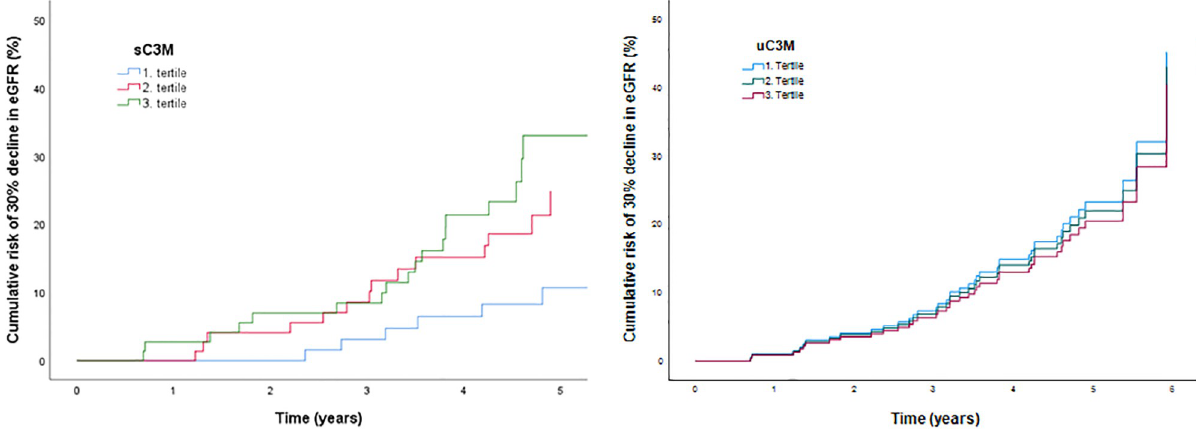
Fig 2. Cox survival plot of decline in eGFR > 3 0% for sC3M and uC3M. Adjustment included sex, age, body mass index, LDL cholesterol, smoking,